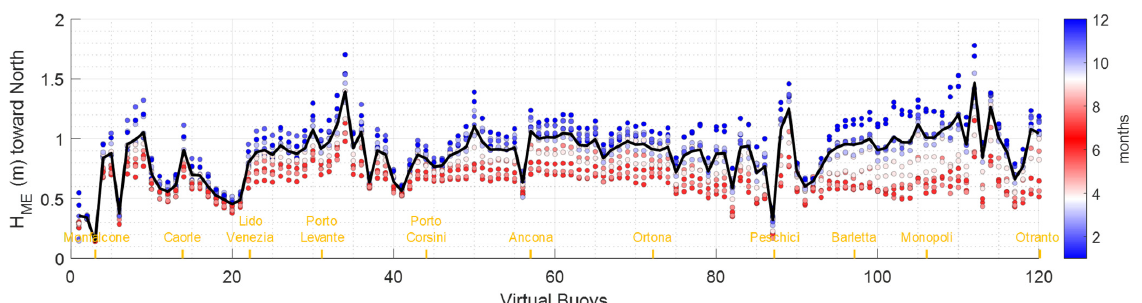
Figure 7. H ME (black line) directed toward north, computed at the 120 virtual buoys along the Italian Adriatic coast relative to the historic run (HR). Colored dots are the monthly H ME at the 120 locations and some locations are highlighted to increase the figure readability.